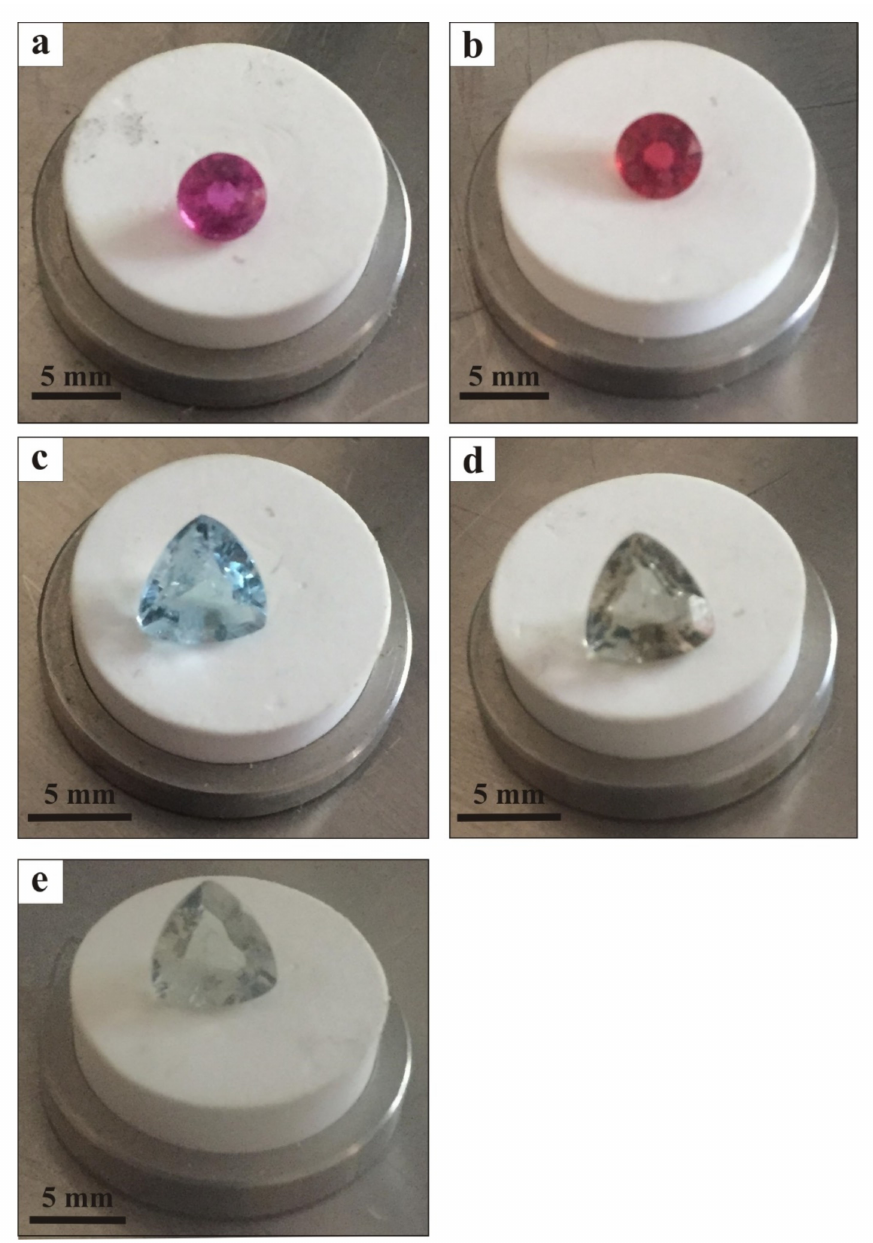
Figure 9. The m glass-filled ruby shows color change after exposure to extreme X-ray dosage ( a , b ). The Skye Blue topaz ( a ) lost most of its color during extreme radiation ( c , d ) and despite hot water treatment and a seven-month recovery period the color was not fully restored ( e